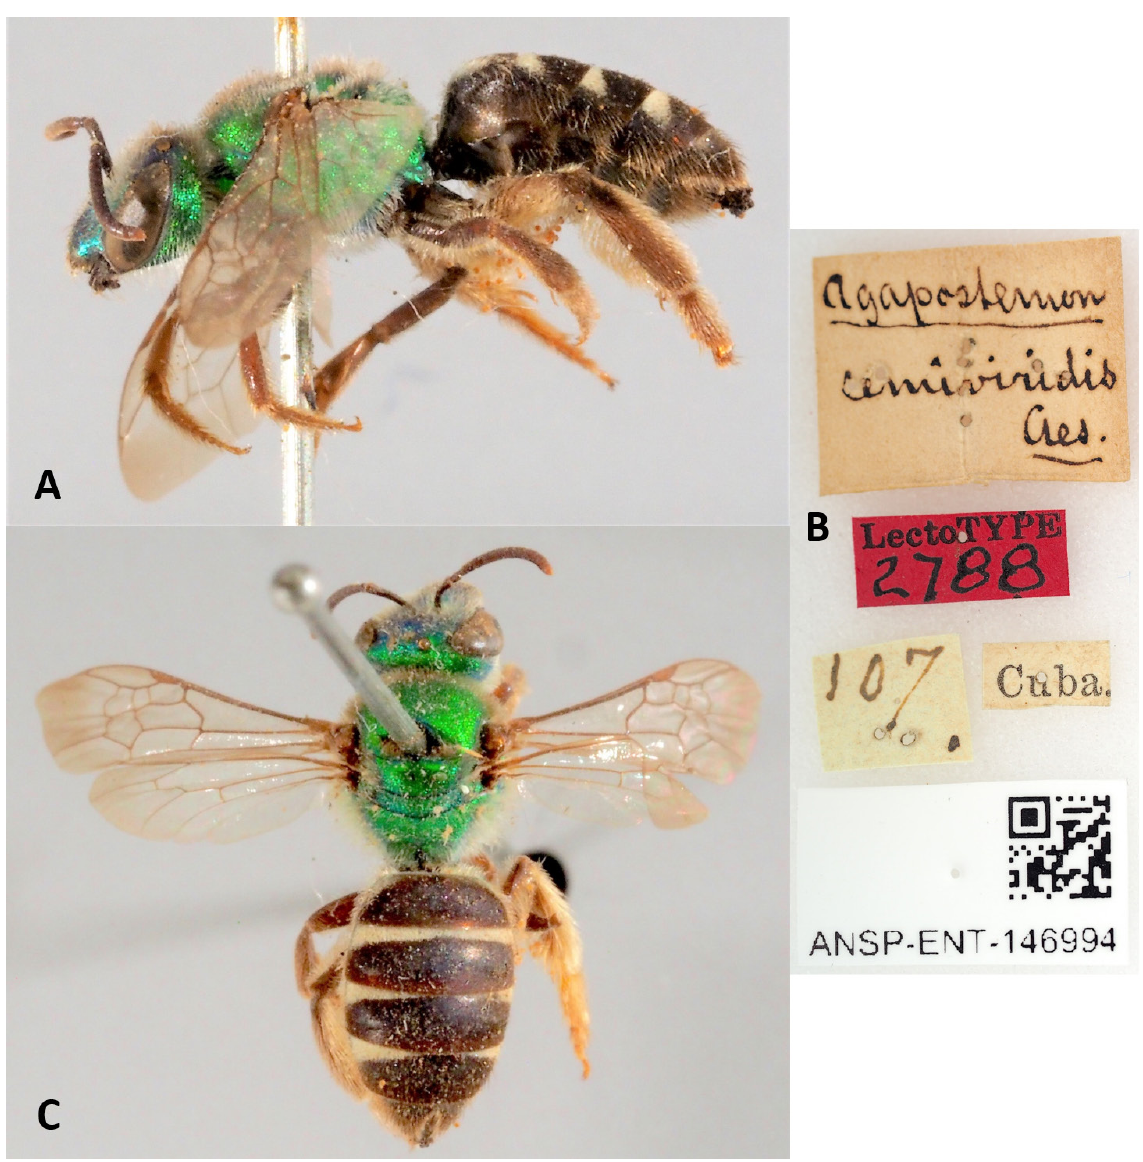
Fig. 4. Agapostemon semiviridis Cresson, 1865. Lectotype, ♀ (ANSP 2788). A . Lateral view. B . Associated labels. C . Dorsal view. Photos by J.D. Weintraub/ANSP